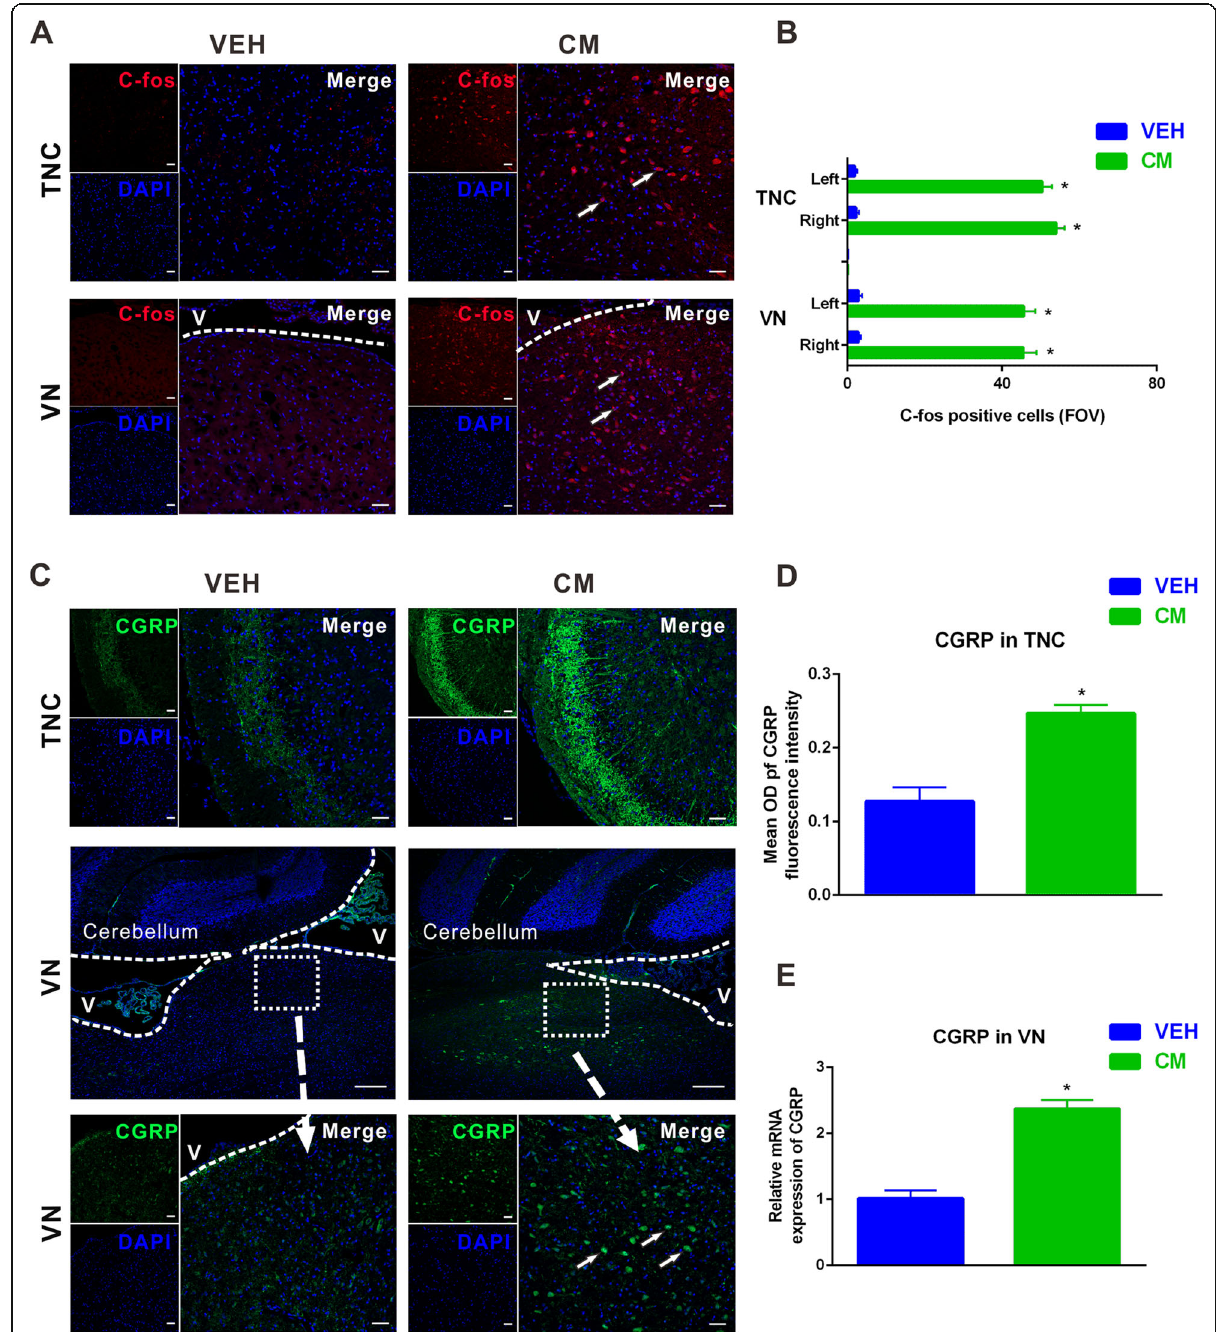
Fig. 3 Upregulation of c-fos and calcitonin gene-related peptide (CGRP) in the trigeminal nucleus caudalis (TNC) and vestibular nuclei (VN) after CM. a Representative images of c-fos (red)-positive staining in the TNC and VN post CM. b Quantification of c-fos + cells in right and left sides of TNC and VN, showing significantly increased number of c-fos + cells after CM compared with vehicle group. FOV = 1.02 × 10 6 μ m 3 . c Representative images of CGRP (green)-positive staining in the TNC (upper panel) and VN (middle and lower panel) after CM. Data showed that CM group had greater CGRP signals ( d ) in the TNC compared with vehicle group. e qRT-PCR results showed that the mRNA level of endogenous CGRP significantly increased after CM. a ( c : upper and lower panel) Scale bar = 50 μ m, ( c : middle panel) Scale bar = 100 μ m; * P < 0.05 compared with vehicle, n = 8/group. Data are mean ± SEM. Student ’ s t -test. V: